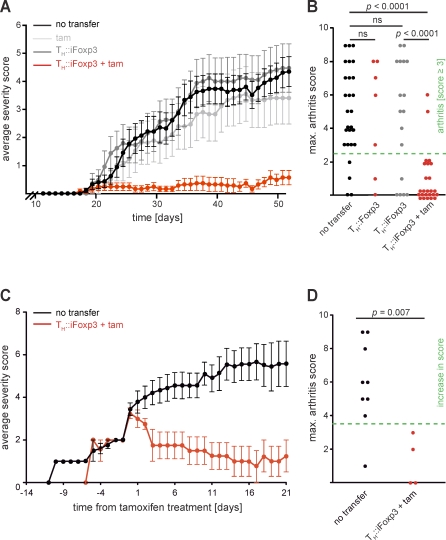
TH::iFoxp3 Cells Suppress Collagen-Induced Arthritis upon iFoxp3 Induction(A and B) Arthritis was induced on day 0 by immunization with cII in CFA.(A) Mice that received 1 × 106 TH::iFoxp3 cells (dark grey, n = 17), mice that did not receive any further treatment (black, n = 27), mice that received tamoxifen injections (light grey, n = 14), and mice that received 1 × 106 TH::iFoxp3 cells and tamoxifen injections to induce iFoxp3 (red, n = 25) are shown. The average arthritis scores of all mice in the groups are shown for each day.(B) Maximum arthritis score reached by individual animals that had received no transfer of cells, TH::Foxp3 cells (see Figure 1A), and TH::iFoxp3 cells ± tam. tam, tamoxifen.(C and D) Arthritis was induced by immunization with cII in CFA.(C) Mice that had received 1 × 106 TH::iFoxp3 cells the day before cII immunization and tamoxifen injections (red, n = 4) when the mice reached a score of 3 (day 0) and mice that did not receive any further treatment (black, n = 9) are shown.(D) Maximum arthritis score reached by individual animals. Error bars represent the SEM, and p-values were determined by Fisher's Exact Test.